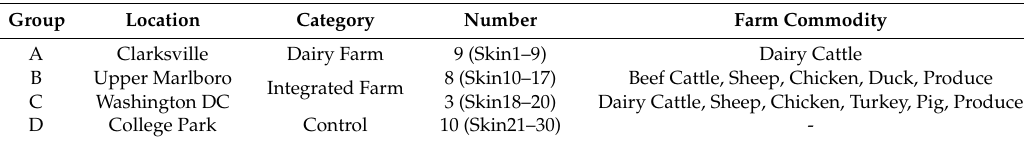
Table 1. Sample sources and